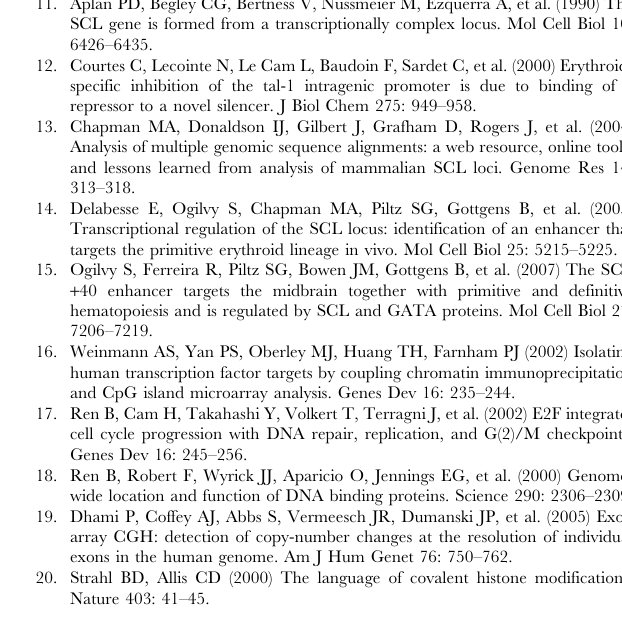
the second column. Genomic sequence co-ordinates are from NCBI build 35. Table S2 Oligonucleotide primer pairs used to PCR amplify array elements for the human SCL tiling array. Amplicon names used in our laboratory are shown in the first column. Amplicon sizes and genomic sequence co-ordinates are from NCBI build 35. Table S3 Antibodies used for ChIP-chip assays performed in this study. Antibodies for histone modifications, transcription factors, histones and antisera controls are listed along with their supplier and catalogue numbers. Table S4 Oligonucleotide primer pairs used to PCR amplify the regions cloned into the pGL3 luciferase reporter constructs. Construct names in the first column are as described in Figure 4. The BamHI, Kpn1 and HindIII sites added to the sequence of each primer are shown in brackets. Amplicon sizes and genomic sequence co-ordinates are from NCBI build 35. Table S5 Oligonucleotide primer pairs used to PCR amplify the regions cloned into the enhancer blocking reporter constructs. Construct names in the first column are as described in Figure 4. The AscI sites added to the sequence of each primer are shown in brackets. Amplicon sizes and genomic sequence co-ordinates are from NCBI build 35.